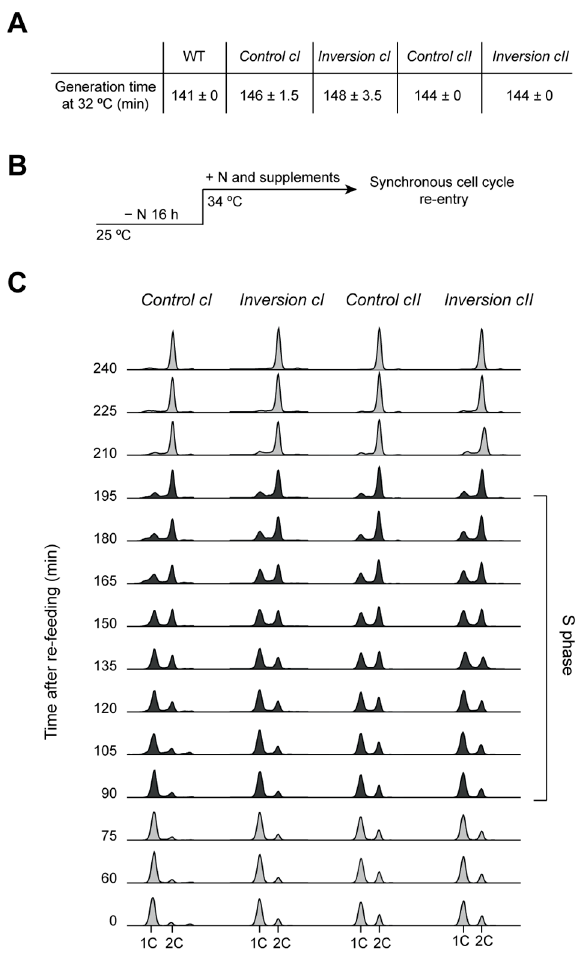
Figure 1. Characterization of cells harboring chromosomal inversions. ( A ) The generation times of the two inversion strains, along with the two parental strains, are virtually identical to that of wild-type (WT) cells. Cells were grown in EMM6S at 32 °C. Averages and standard errors of two independent experiments are shown. ( B ) Experimental design for nitrogen depletion and cell cycle exit, followed by synchronous re-entry into a proliferative cycle. Cells were grown to exponential phase in EMM6S, starved of nitrogen at 25 °C for 16 h, and induced to re-enter the cell cycle upon addition of NH 4 Cl. To allow for comparisons with pre-meiotic S phase and meiotic progression in the pat1- 114 background (see Figure 4), cultures were shifted to 34 °C, the restrictive temperature for pat1- 114, at the time of NH 4 Cl addition. ( C ) DNA content analysis of the first S phase during cell cycle re-entry from quiescence. NH 4 Cl was added to the medium at T = 0. Time points during which cells undergo bulk S phase are indicated in black. S phase onset and duration are identical in the Control and Inversion strains.